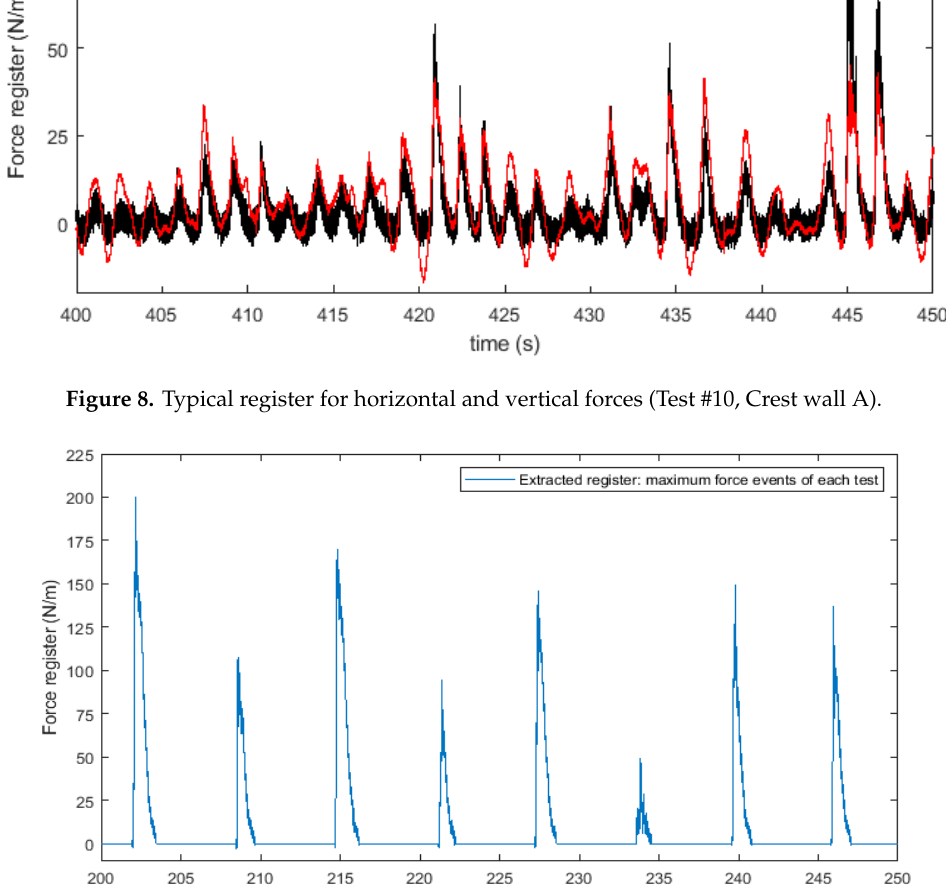
Figure 8. Typical register for horizontal and vertical forces (Test #10, Crest wall A).